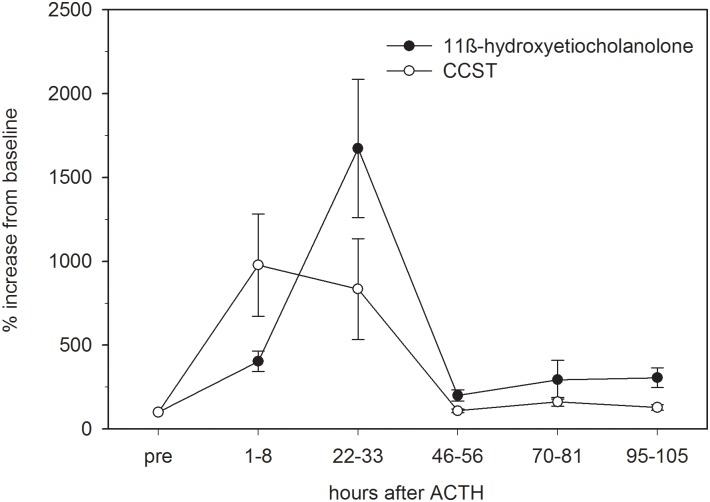
Percentage of response in immunoreactive fecal 11β-hydroxyetiocholanolone and CCST levels to ACTH administration in meerkats.Data points represent mean ± SE values calculated for 8-12-h intervals across the 14 individuals that responded to the ACTH challenge. Percentages were calculated in relation to pre-treatment baseline values (pre = 100%).